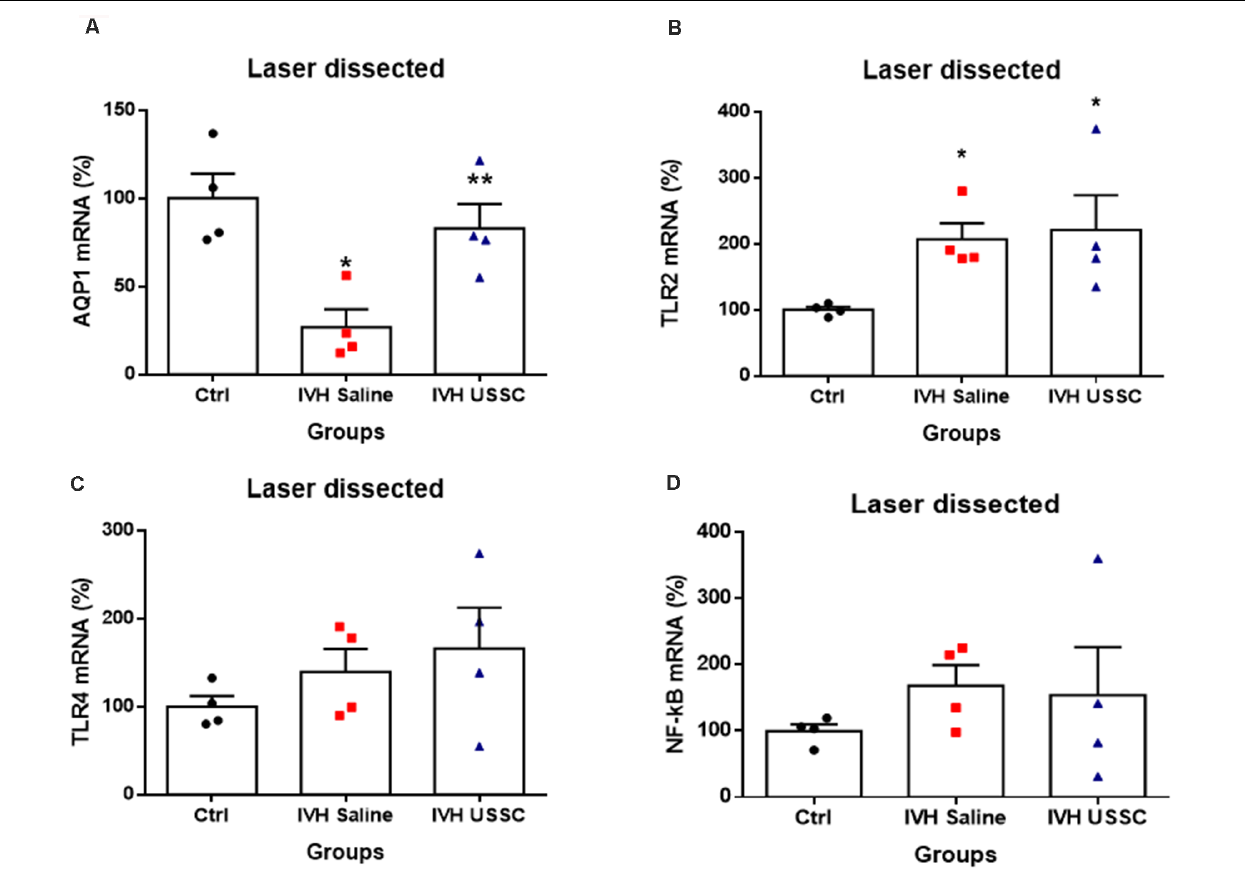
FIGURE 4 | USSC administration mitigates AQP1 expression and does not suppress toll like receptors (TLRs) in choroid plexus epithelium during early IVH injury at postnatal day 3. (A–D) Scatter plot bar graphs showing TaqMan gene expression assay using laser dissected choroid plexus RNA at postnatal day 3. (A) Reduced AQP1 mRNA expression in IVH compared with healthy controls in laser dissected tissue region; after the USSC treatment, expression was recovered to normal (* P < 0.05 for Ctrl vs. IVH, ** P < 0.05 for IVH vs. USSCs; n = 4 in each group). (B) Increased mRNA levels for TLR-2 after IVH independent of USSC treatment (* P < 0.05 for Ctrl vs. IVH and Ctrl vs. USSC; n = 4 in each group). (C–D) For both TLR4 and NF-kB mRNA, levels were comparable between the three interventional groups. (p –ns). The data represent mean ± SEM; for postnatal day 3. P -values were derived by one-way ANOVA with Tukey’s multiple comparisons